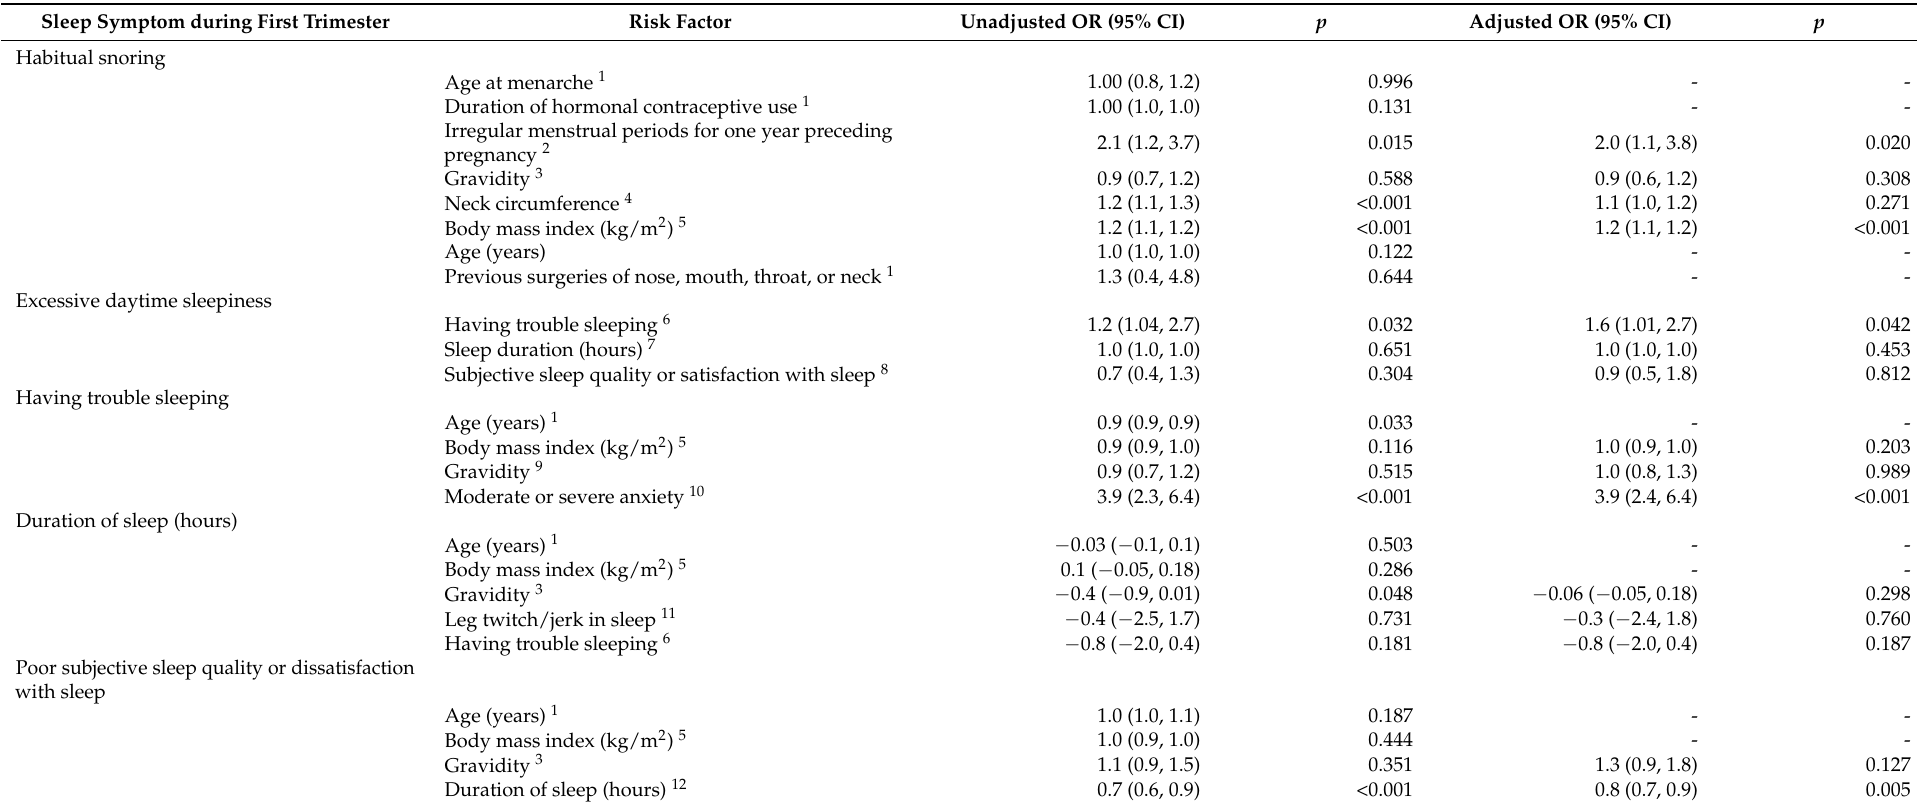
Table 4. Risk factors for common sleep symptoms during first